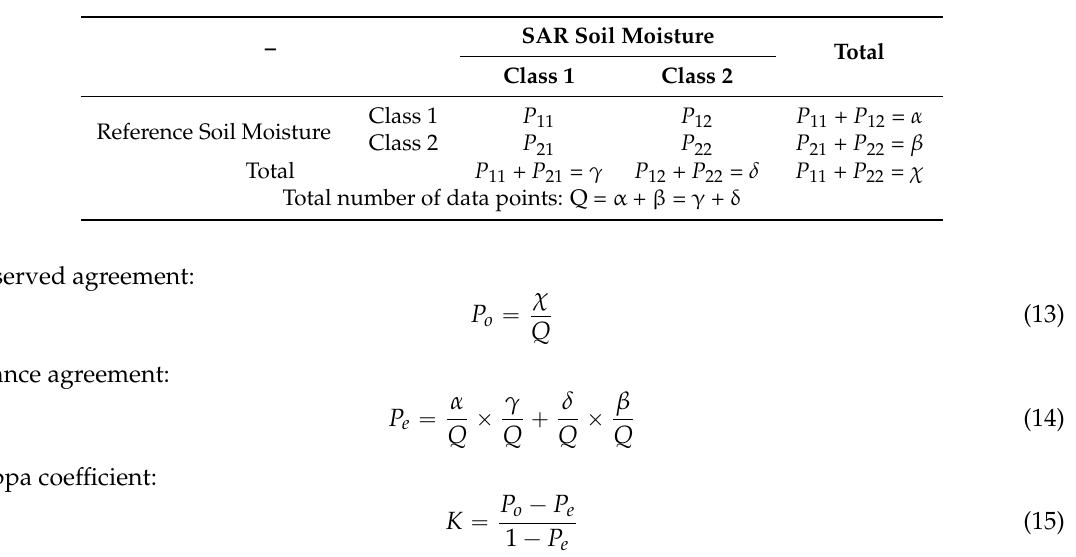
Table 4. Computation of Kappa